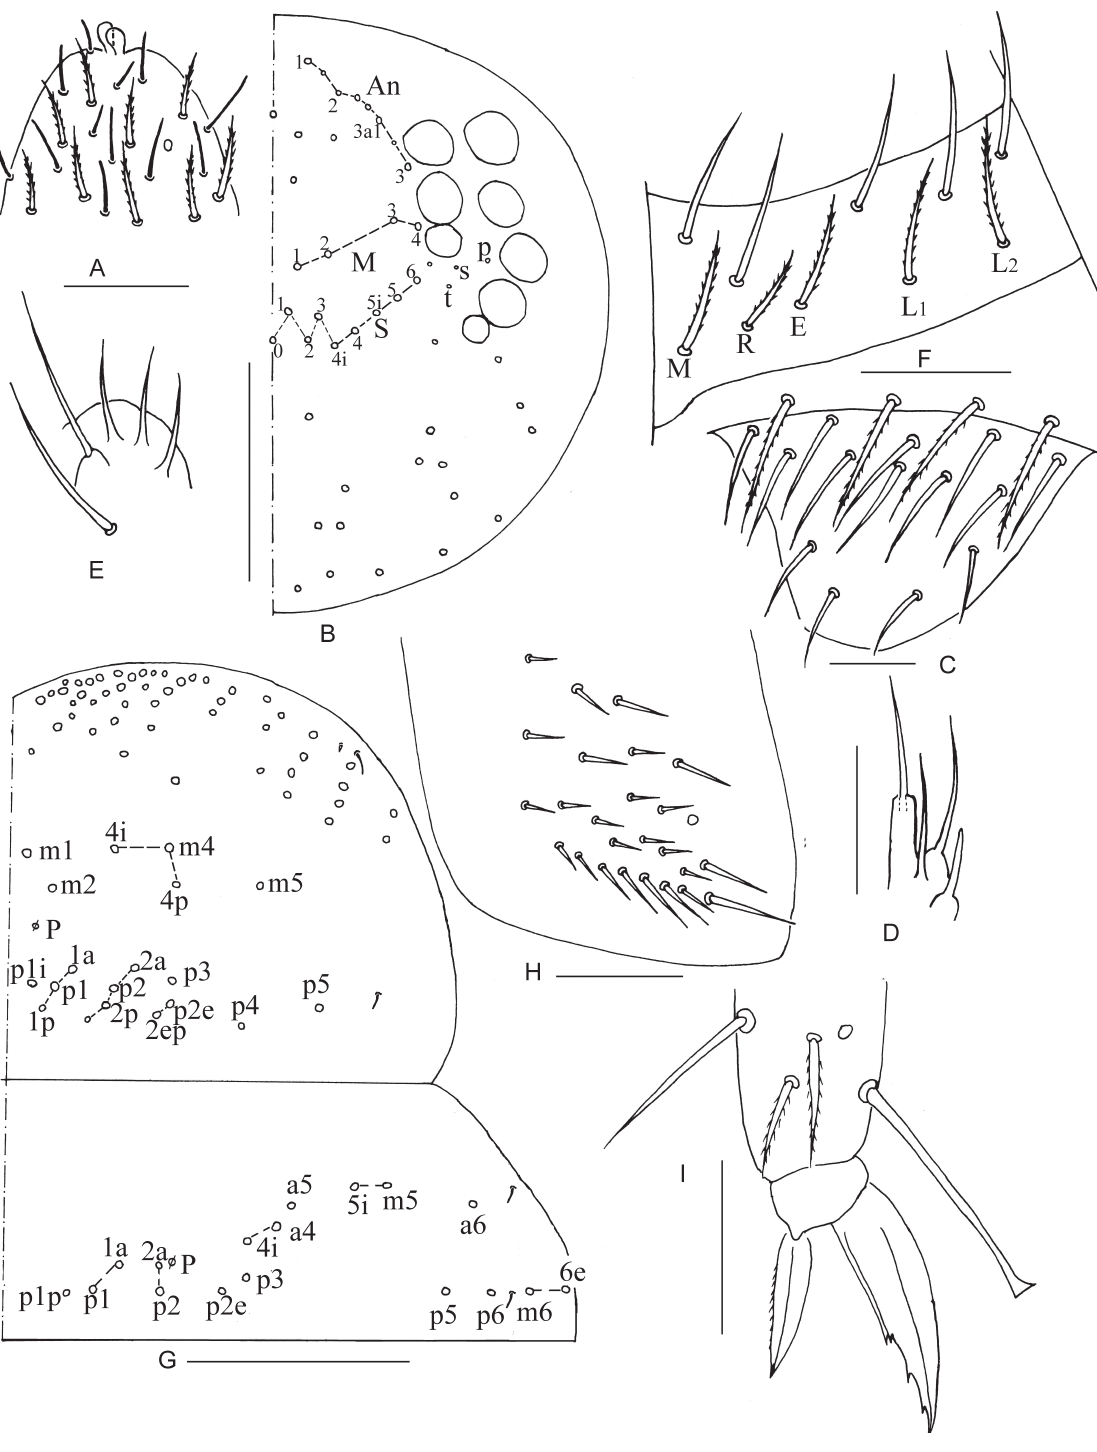
Fig. 9. Willowsia tanae sp. nov. A . Apex of Ant. IV. B . Dorsal chaetotaxy of head. C . Labrum. D . Lateral process of labial palp. E . Maxillary outer lobe. F . Labium. G . Chaetotaxy of Th. II−III. H . Trochanteral organ. I . Foot complex. Scale bars: A, C−F, H–I = 20 μm; B, G = 100